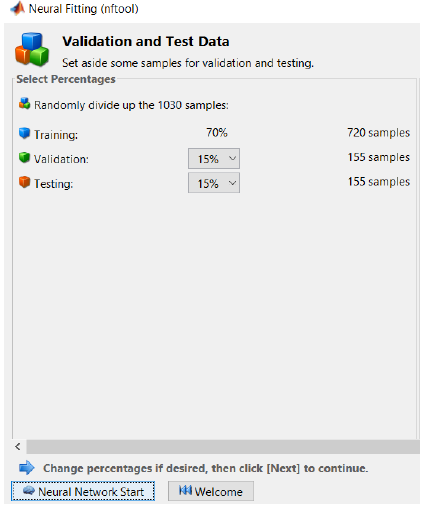
Figure 5. Dividing up samples.